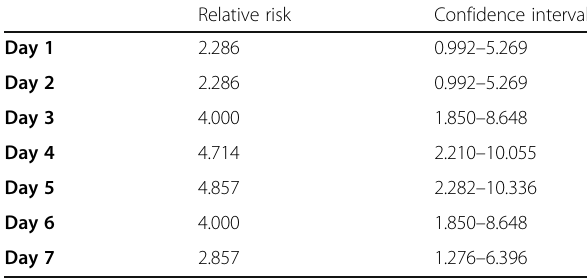
Table 2 Relative risk for the occurrence of migraine on each day of the hormone free interval compared to the pooled risk of day 8 – 28 Relative